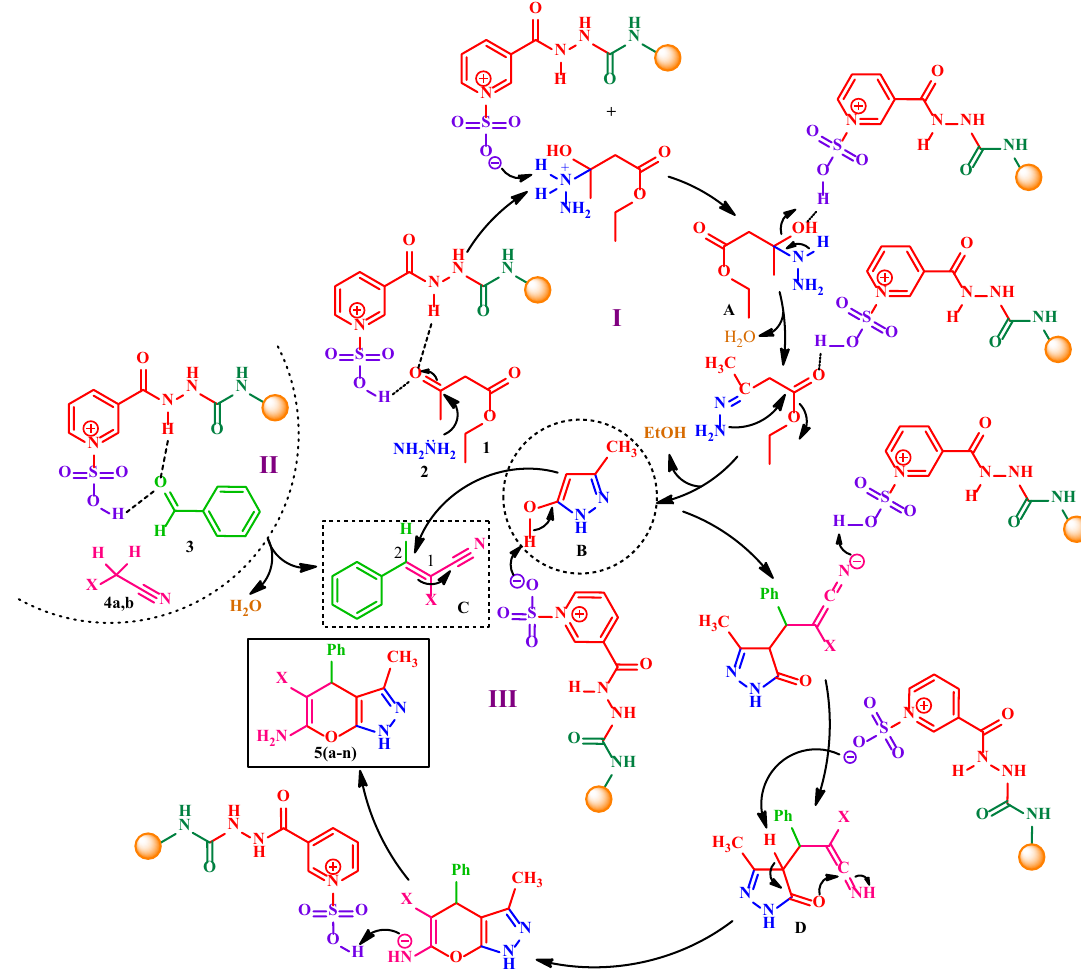
Figure 15. The proposed mechanism for the synthesis of diverse pyranopyrazoles 5(a-n)